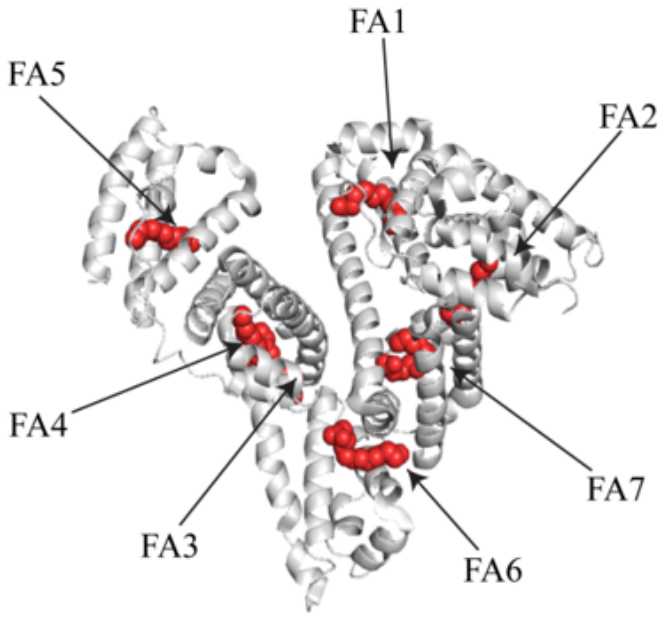
Figure 3. 3-D model of HSA showing the seven fatty acid (FA) binding sites. Myristate occupying the seven sites is rendered in red spheres. The 3-D model was generated by PyMOL using 1HK4 PDB file.